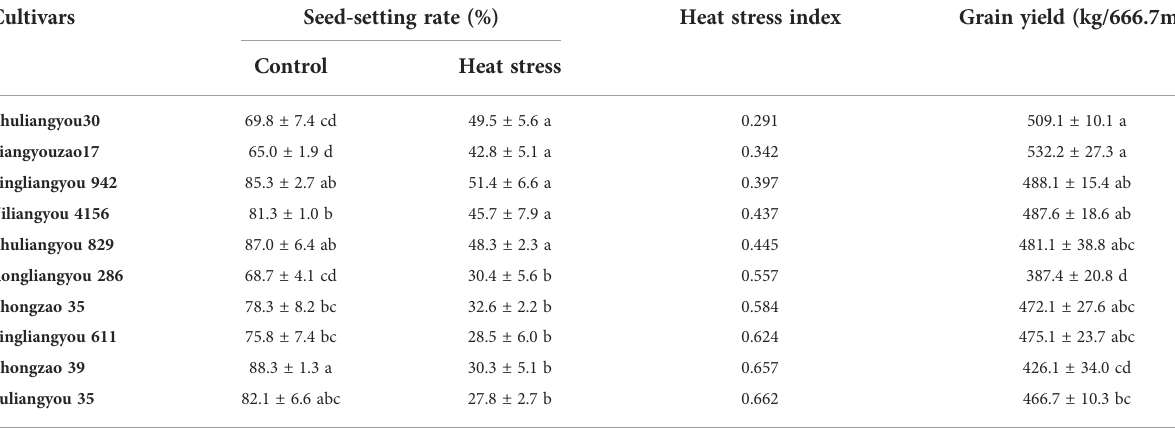
TABLE 2 The seed-setting rate, heat stress index and yields vary among 10 early indicia rice varieties with different heat tolerance and yield.